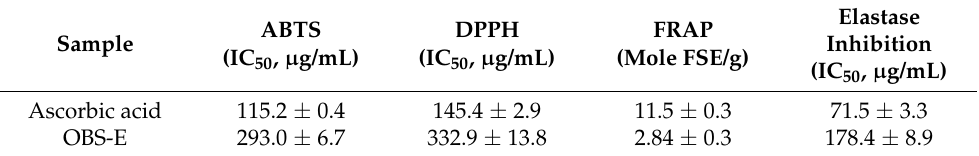
Table 1. Antioxidant and elastase inhibitory activities of Oenothera biennis sprout extract (OBS-E).